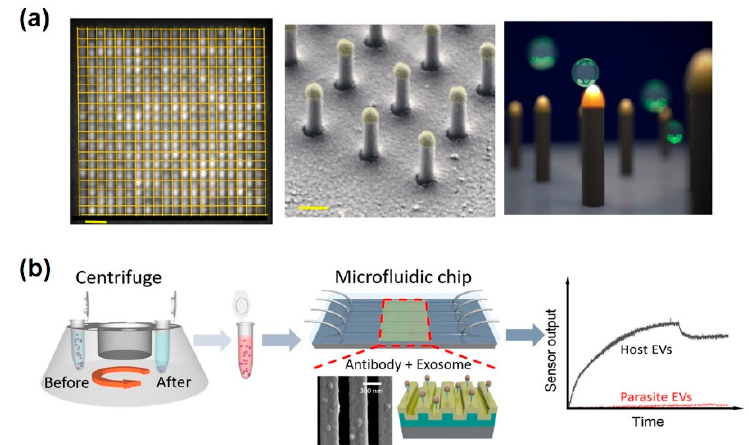
Figure 8. LSPR-based immunosensors for extracellular vesicle detection. ( a ) LSPRi sensor chip and high-magnification false-colored SEM image showing individual nanopillars, allowing digitized exosome detection. Scale bars are 1 μ m and 200 nm, respectively; ( b ) microfluidic photonic crystal biosensor for the detection of host and parasitic exosomes. ( a ) Figure reproduced with permission from [91], © 2018 Plos one, ( b ) Figure reproduced with permission from [92], © 2018 American Chemical Society.